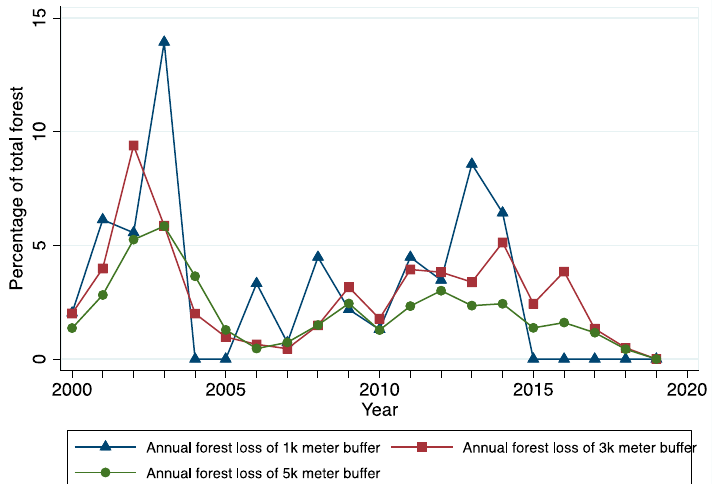
Figure 12. Yearly deforestation rate for Village D in 1000-, 3000-, and 5000-m buffers, 2000–2019.